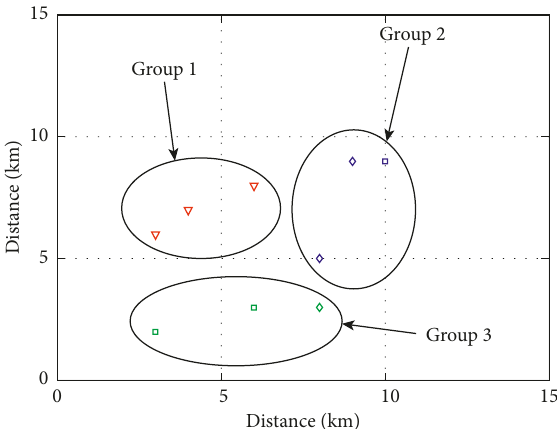
Figure 7: Division of targets into groups of three targets each. The square symbol indicates high-priority targets, the diamond symbol shows medium-priority targets, and the triangle symbol shows low- priority targets.